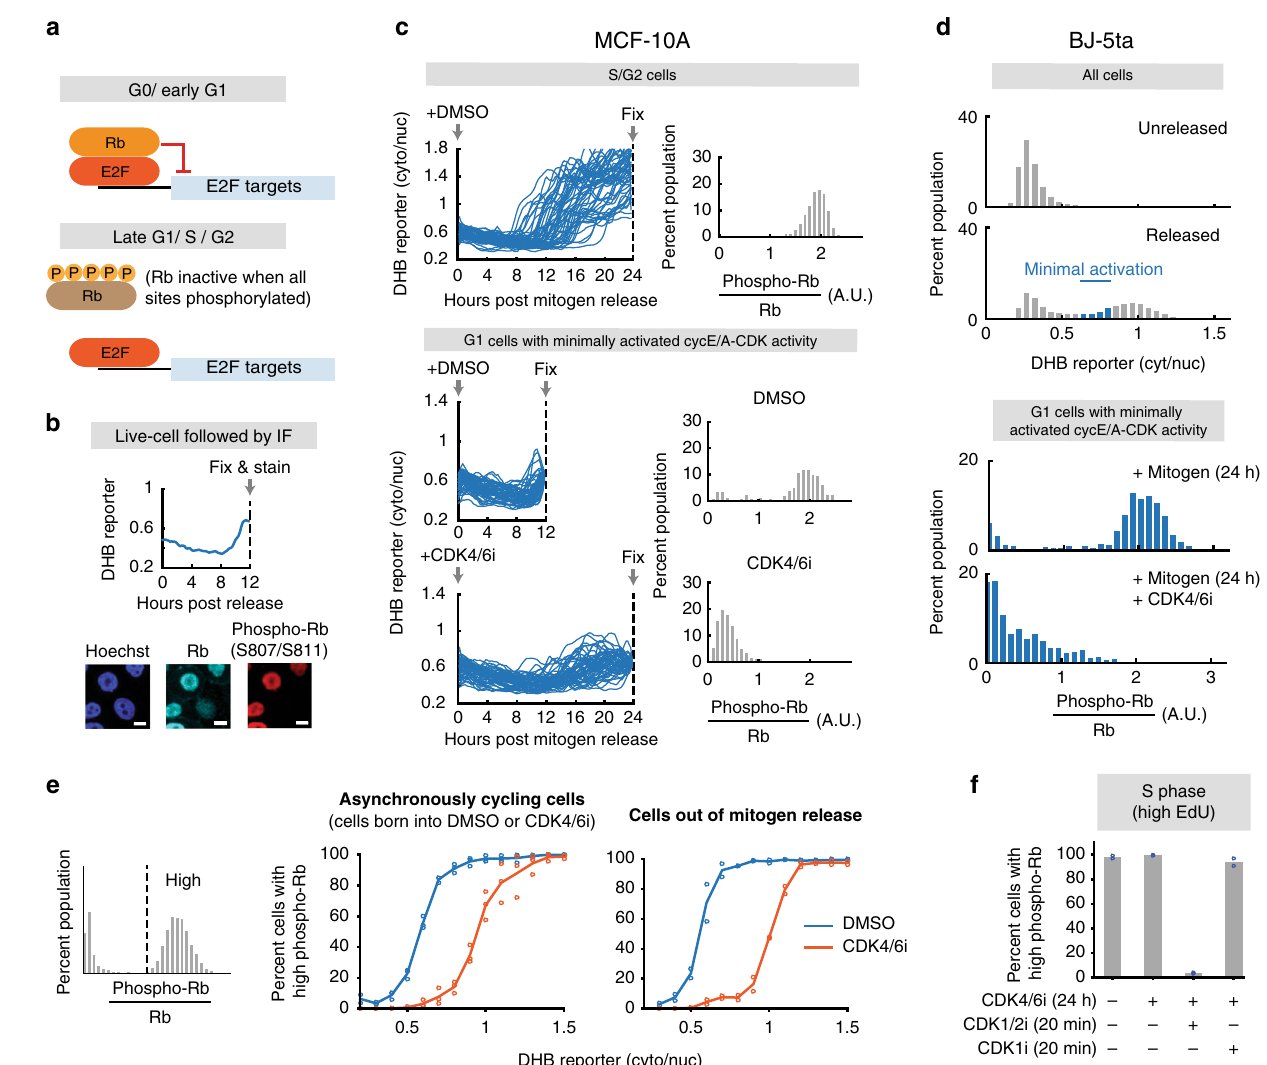
Fig. 3 Cyclin E-CDK2 is activated without Rb hyperphosphorylation in cells lacking CDK4/6 activity. a E2F is active when Rb is hyperphosphorylated. b Phospho-Rb analysis after live-cell tracking of cyclin E/A-CDK activity. Scale bar = 10 µ m. c Phospho-Rb(S807/S811) analysis of cells that have inactivated APC/C CDH1 (top; 50 cells plotted, 2315 cells total), and cells that have initiated cyclin E/A-CDK activity and have not inactivated APC/C CDH1 (bottom; 50 cells plotted, 364, 1023 cells for DMSO and CDK4/6 inhibitor). One of n = 3 biological replicates. d BJ-5ta cells expressing the cyclin E/A- CDK activity reporter and APC/C degron reporter were mitogen released with or without 1 µ M CDK4/6 inhibitor, fi xed after 24 h, and stained for Rb and phospho-Rb(S807/S811). G1 cells with recently activated cyclin E/A-CDK activity were analyzed. n = 703 and 383 cells for DMSO and CDK4/6i condition. e Cells were grouped into high and low phospho-Rb(S807/S811) signal populations. The percentages of cells with high signal were then determined for each bin of the cyclin E/A-CDK activity. Middle: Cells born into DMSO or CDK4/6 inhibitor. Mean of n = 3 biological replicates. Right: Cells mitogen released with DMSO or CDK4/6 inhibitor. Mean of n = 2 biological replicates. f Asynchronously cycling cells treated with or without CDK4/6 inhibitor for 24 h. Cells were then incubated with 10 µ M EdU for 15 min, and then treated with DMSO, CDK1/2i (3 µ M), or CDK1i (10 µ M) for 20 min. Cells were then fi xed and high EdU signal cells were examined. Mean of n = 2 biological